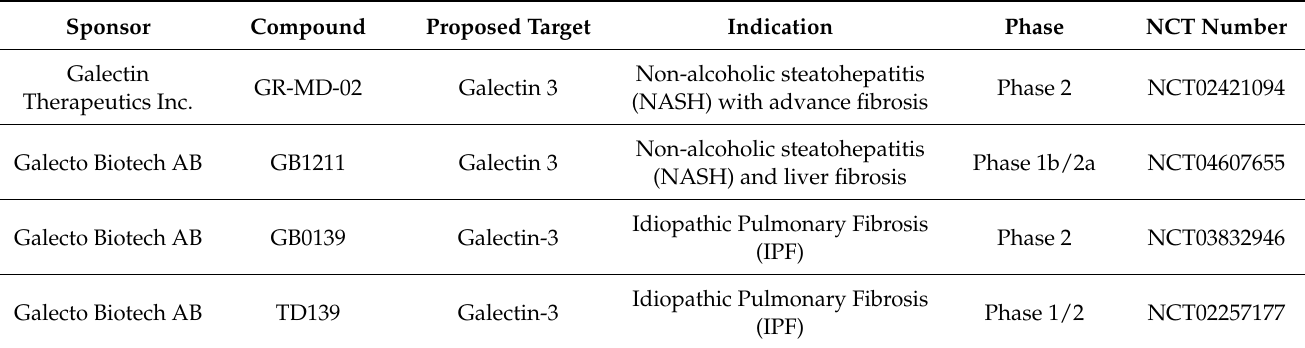
Table 1. Clinical trials targeting the galectins for the treatment of